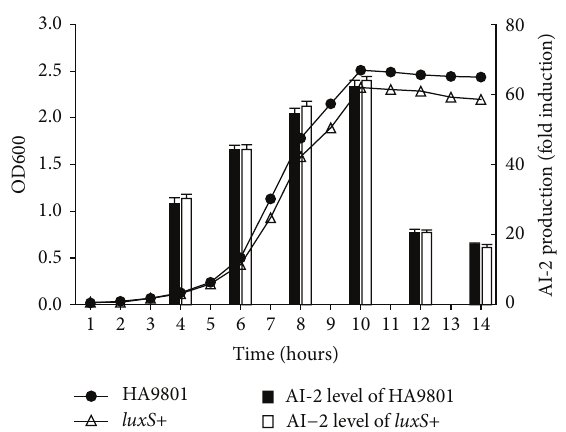
Figure 3: Production of AI-2 activity of the different strains. AI- 2 activity of cell-free culture fluids in the stationary exponential phase was measured using the V. harveyi bioluminescence assay. AI-2 activity determination is expressed as relative light units and compared with the level of luminescence produced by the positive control ( V. harveyi BB120). AI-2 activity of V. harveyi BB120 was set to 100% activity for normalization. V. harveyi BB120 served as a positive control and sterile THB medium as a negative control. HA9801, Δ luxS , C Δ luxS , and luxS + refer to the WT strain, the luxS mutant strain, the complementation strain, and the overexpression strain. Values are means from three independent experiments. Error bars indicate standard deviations ( 𝑃 < 0.05